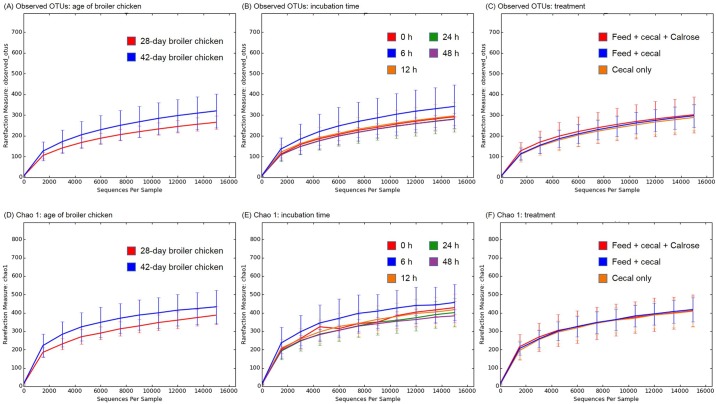
Alpha diversity analysis among groups.Rarefaction curves of (A-C) Observed_OTUs and (D-F) Chao 1.